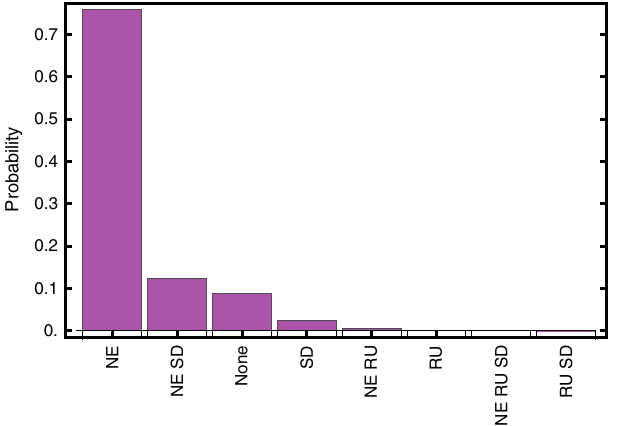
FIG. 9. The simulated distribution of histories of previously undergone pointlike interactions in other collimators for the protons that are finally lost in a nuclear inelastic interaction on the TCTH in IR1 (NE designates nuclear elastic scattering; SD designates single-diffractive scattering; RU designates Ruther- ford scattering). The particles that have not undergone any pointlike interactions have acquired small offsets in angle and energy in repeated passages in collimators through multiple scattering and ionization. Multiple entries of the same physical processes have been grouped together, e.g. the left-most bin contains protons that have undergone nuclear elastic scattering one or several times but no other pointlike